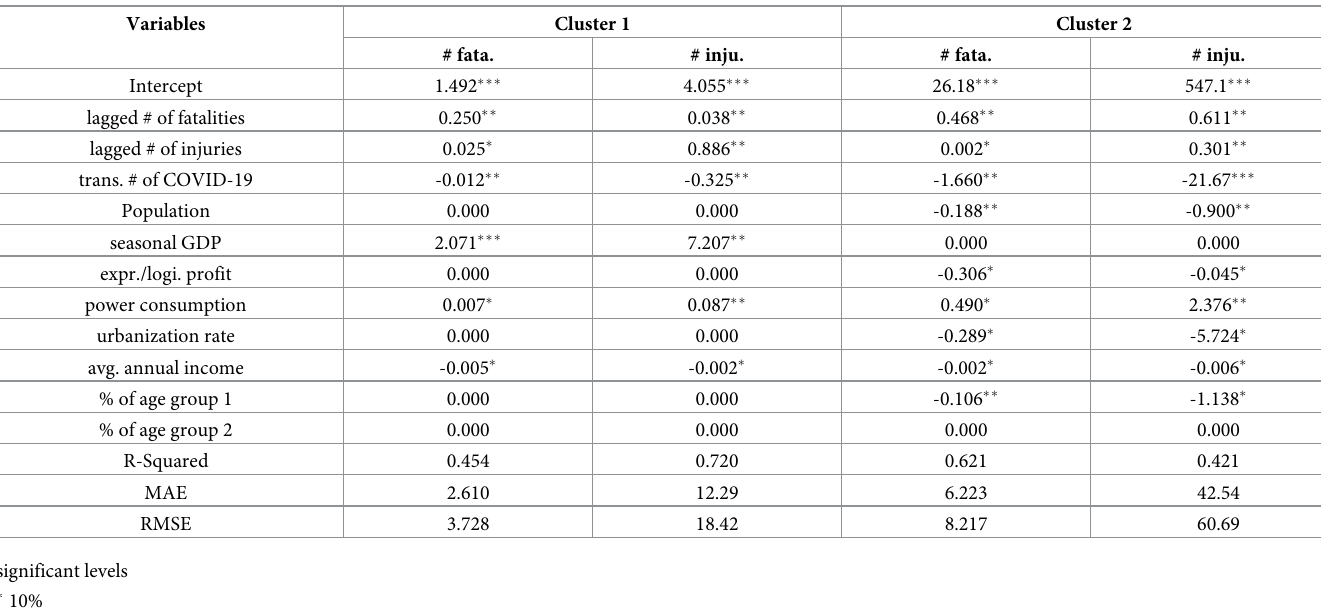
Table 4. Regression results of two